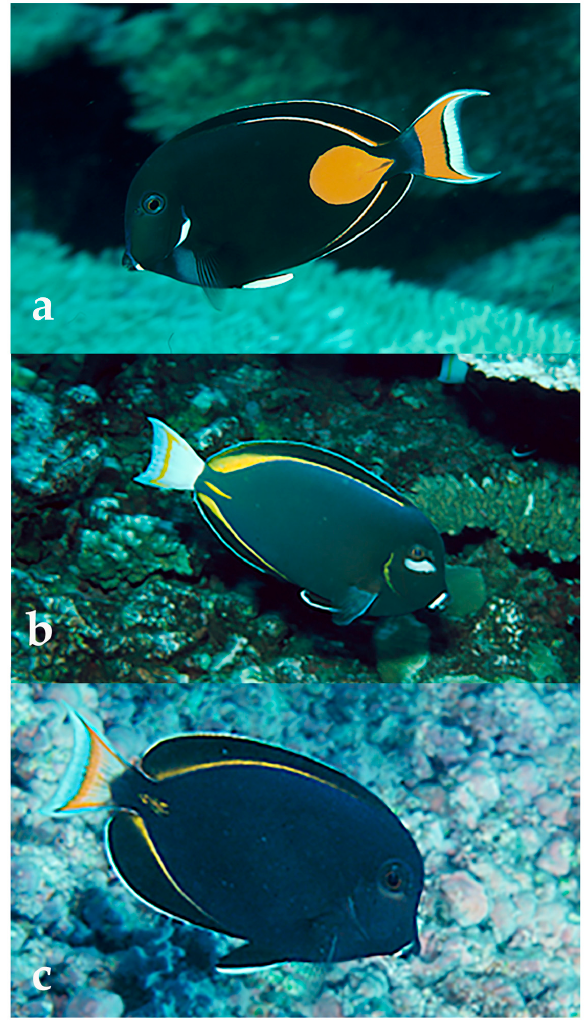
Figure 9. The acanthurids at Johnston Atoll, ( a ) Acanthurus achilles, ( b ) A. nigricans and ( c ) the presumptive hybrid (October, 1996). presumptive hybrid (October,